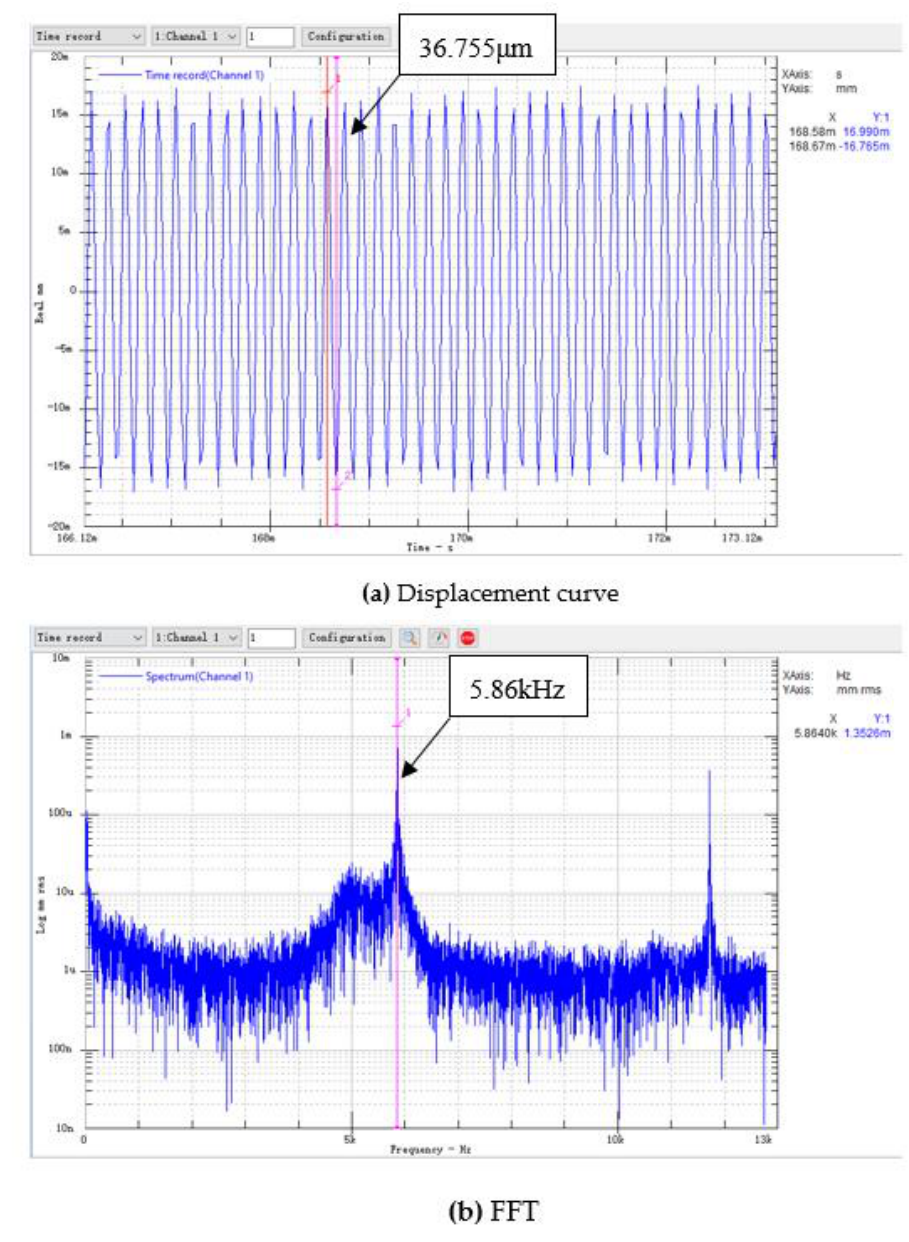
Figure 10. The displacement curve of piezoelectric vibrator no. 1 of prototype #2 at V = 100.8 m / s. For the open-circuit voltage curve of the piezoelectric vibrator, through a spectrum analysis, it was found that the open-circuit voltage frequency was: f V = 5.85 kHz. The main peak of the displacement vibration frequency of the piezoelectric vibrator was read through the frequency spectrum analysis chart of the displacement curve: f X = 5.86 kHz. The error between the output open-circuit voltage frequency f V and the vibration displacement frequency f X of the piezoelectric vibrator was only 10 Hz, and the relative error was only 0.17%. It can be considered that the two frequencies were consistent. It was shown in Section 3.1 that the sound pressure frequency of prototype #2 at a flow rate of 101 m / s was f s = 6.11 kHz. The error between the sound pressure frequency f and the vibration displacement frequency f X of the piezoelectric vibrator was 250 Hz, and the relative error was 4.2%. Therefore, it can be considered that the three have consistent frequencies and conform to the calculation results given in Section